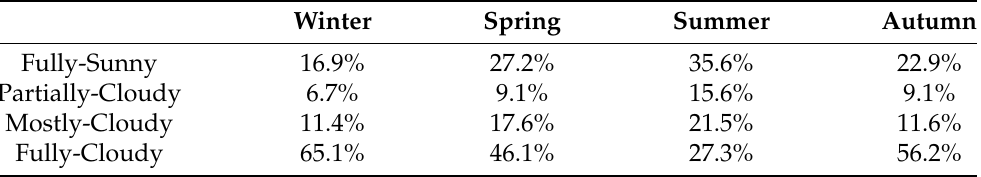
Table 5. Cloudiness index-Paris Orly